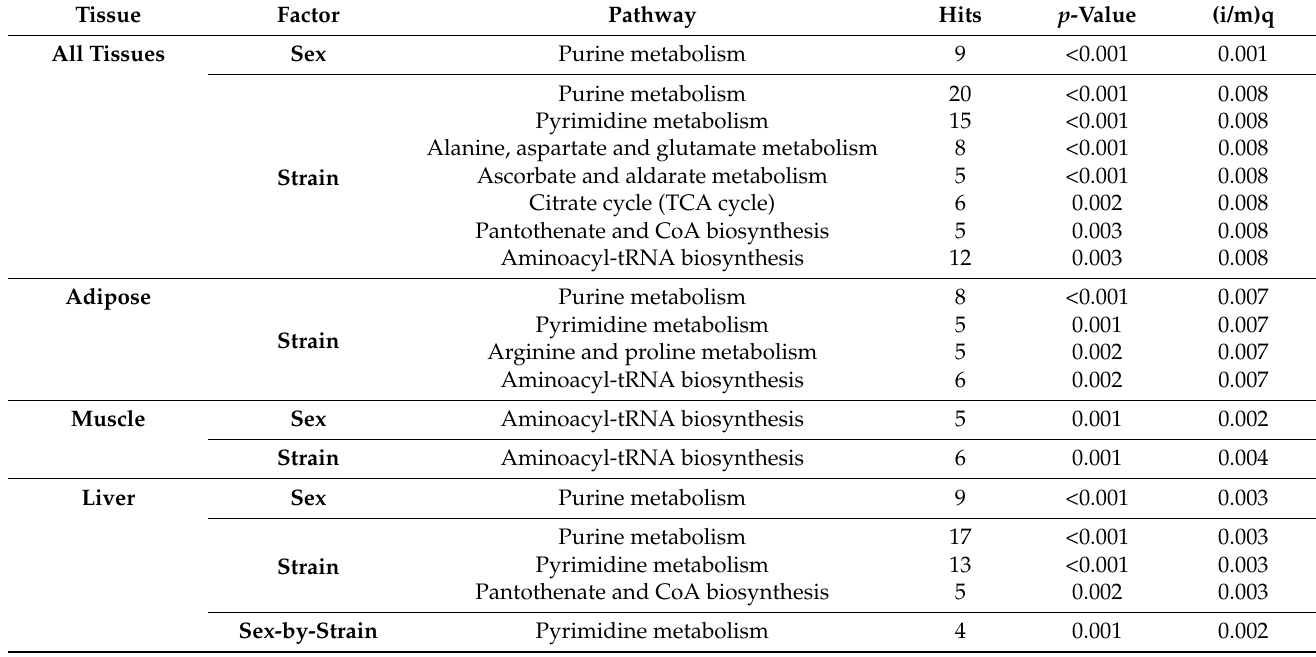
Table 2. KEGG pathway enrichment of metabolites affected by sex, strain, and sex-by-strain.